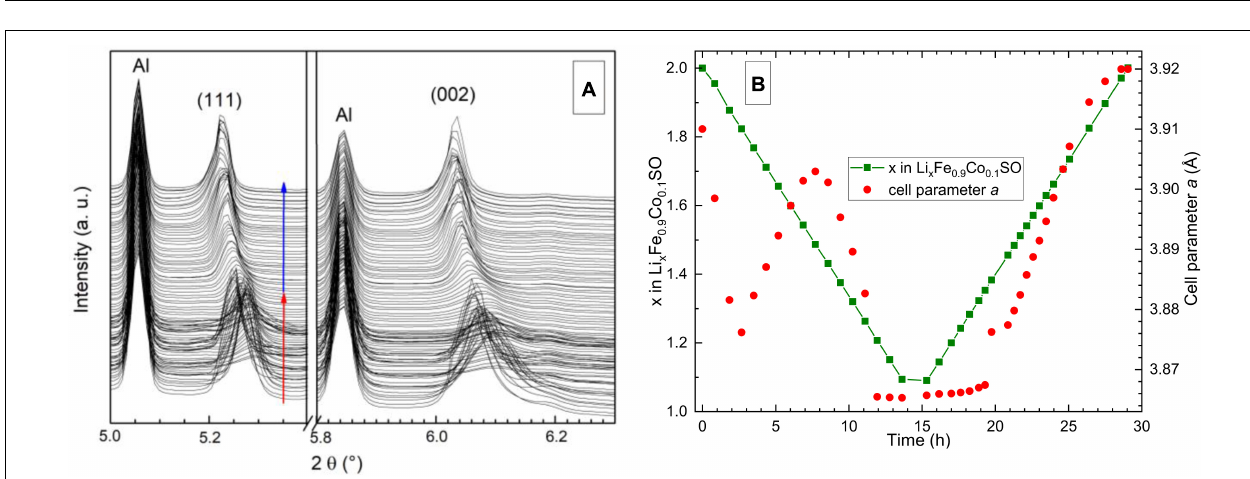
FIGURE 4 | (A) Part of X-ray diffractograms taken operando on ALBA (Barcelona). Red arrows show charge and blue–discharge process. The wavelength was 0.41240 Å. (B) Cell parameter of Li 2 Fe 0 . 9 Mn 0 . 1 SO versus time, and the amount of lithium in the structure during operando XRD measurements. HCP and LCP mean “phase with high cell parameter value” and “phase with low cell parameter value”, respectively.